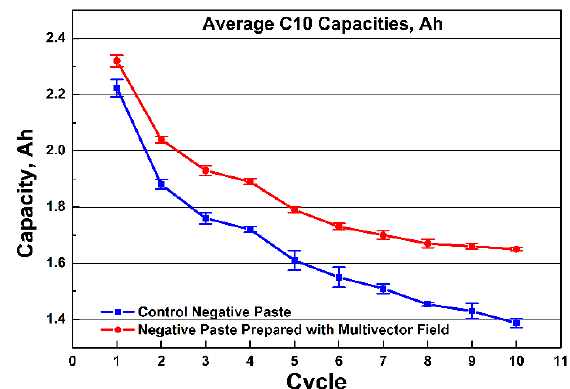
Figure 4. Averaged values form the 10 cycle C10 capacity measurements of the 6 cells with negative electrodes prepared with CP and MVFP.